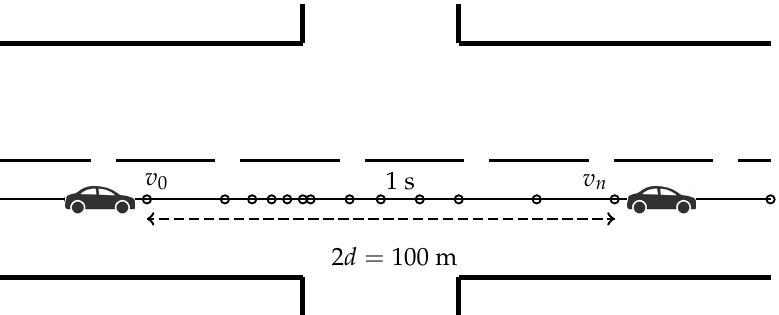
Figure 1. Window of 100 m wide for a driver’s trip in one of the two heading directions of the road